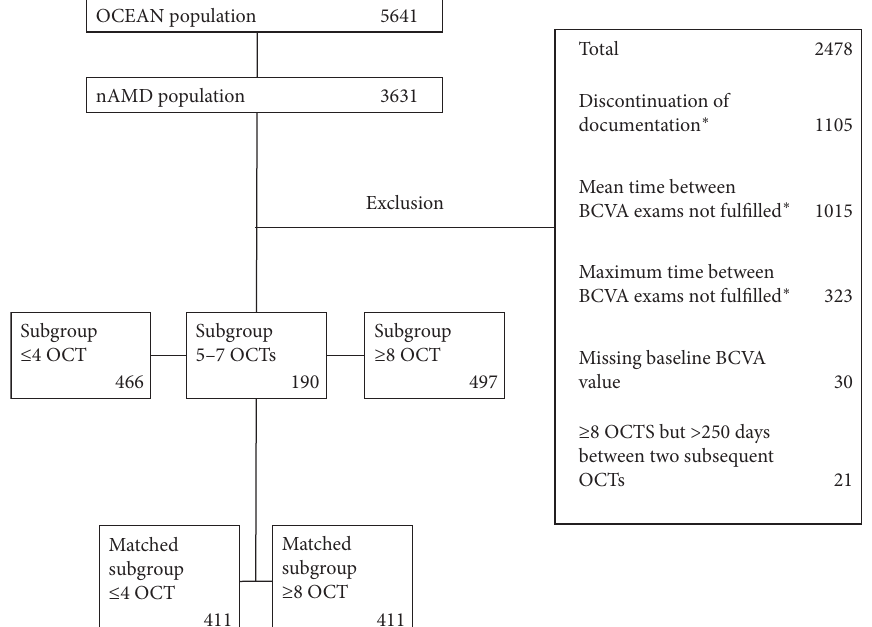
Figure 2: Patient disposition of participants with nAMD in the OCEAN study. ∗ Multiple responses possible. BCVA: best-corrected visual acuity; nAMD: neovascular age-related macular degeneration; OCT: optical coherence Table 2: Patient demographics and baseline disease characteristics of the matched OCT examination subgroups. ≤ 4 OCT matched subgroup, N � 411